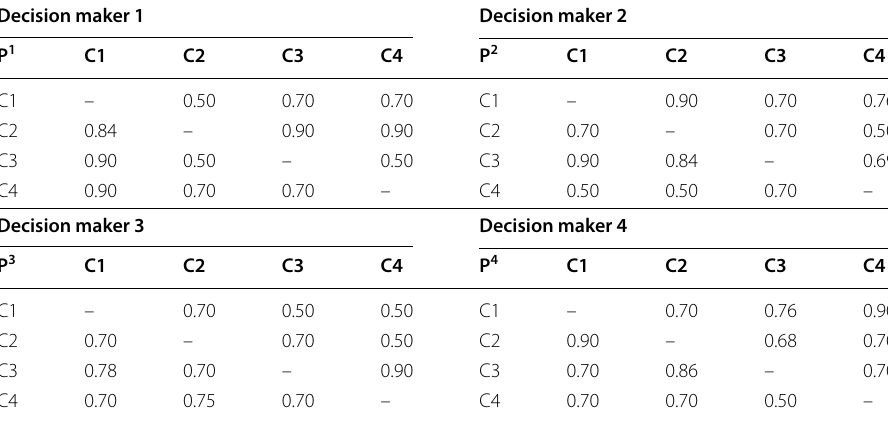
Table 17 Third-round fuzzy preferences for equity sharing model Decision maker